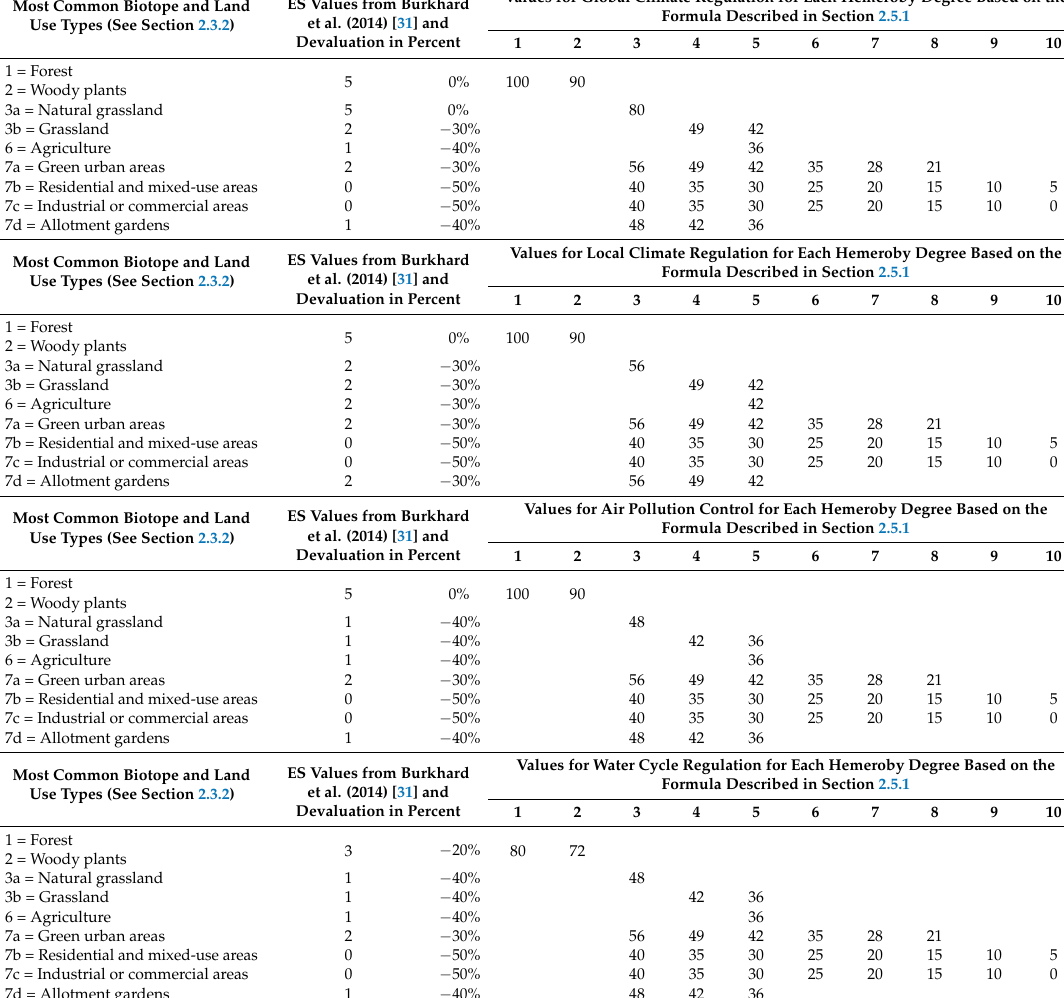
Table 11. Index values for regulating ecosystem services (ES) global climate regulation, local climate regulation, air pollution control, water cycle regulation for the most common biotope or land use type and each hemeroby degree. Value 100 = highest ecosystem service capacity; 0 = lowest/no ecosystem service